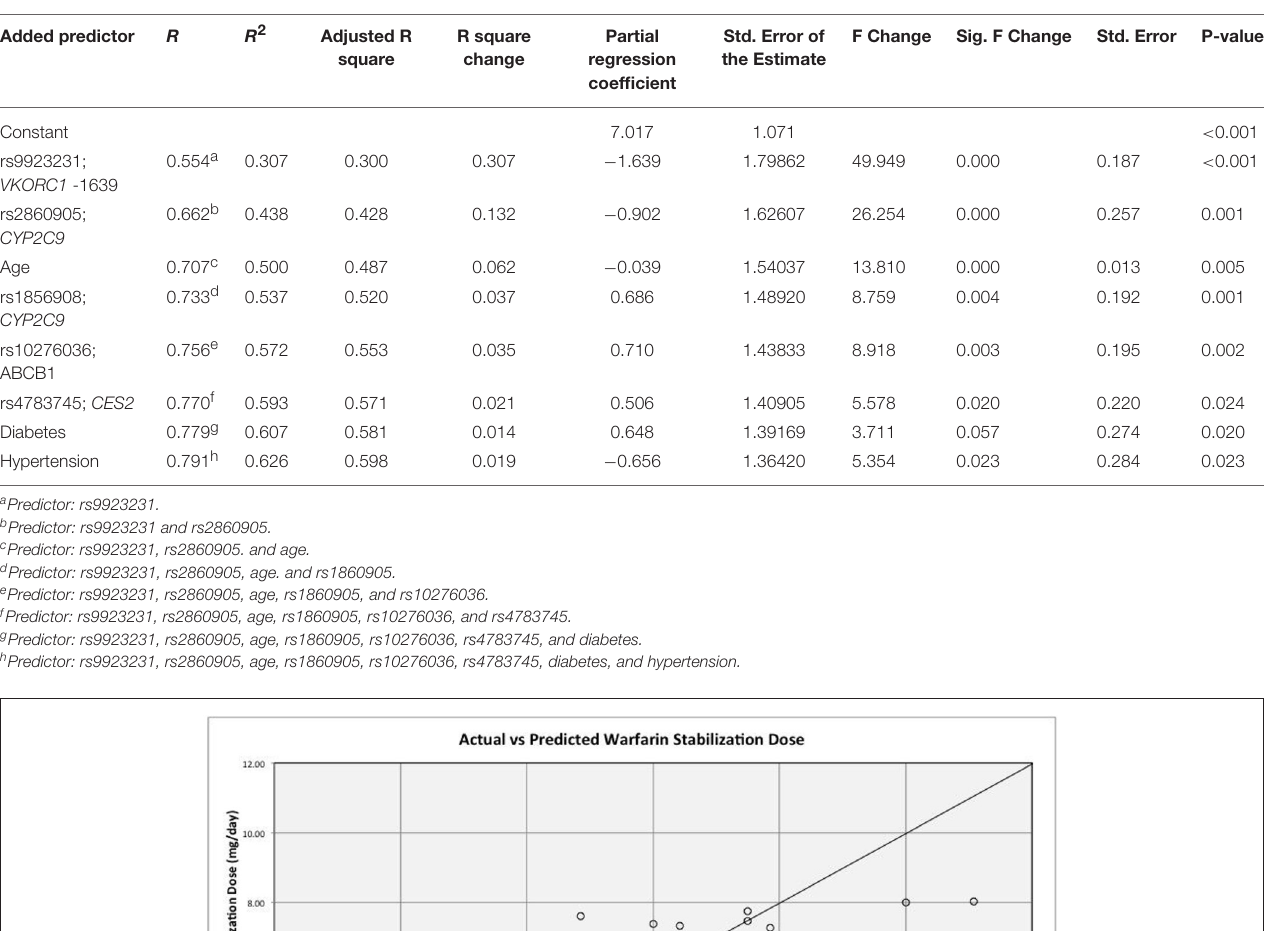
Partial square regression